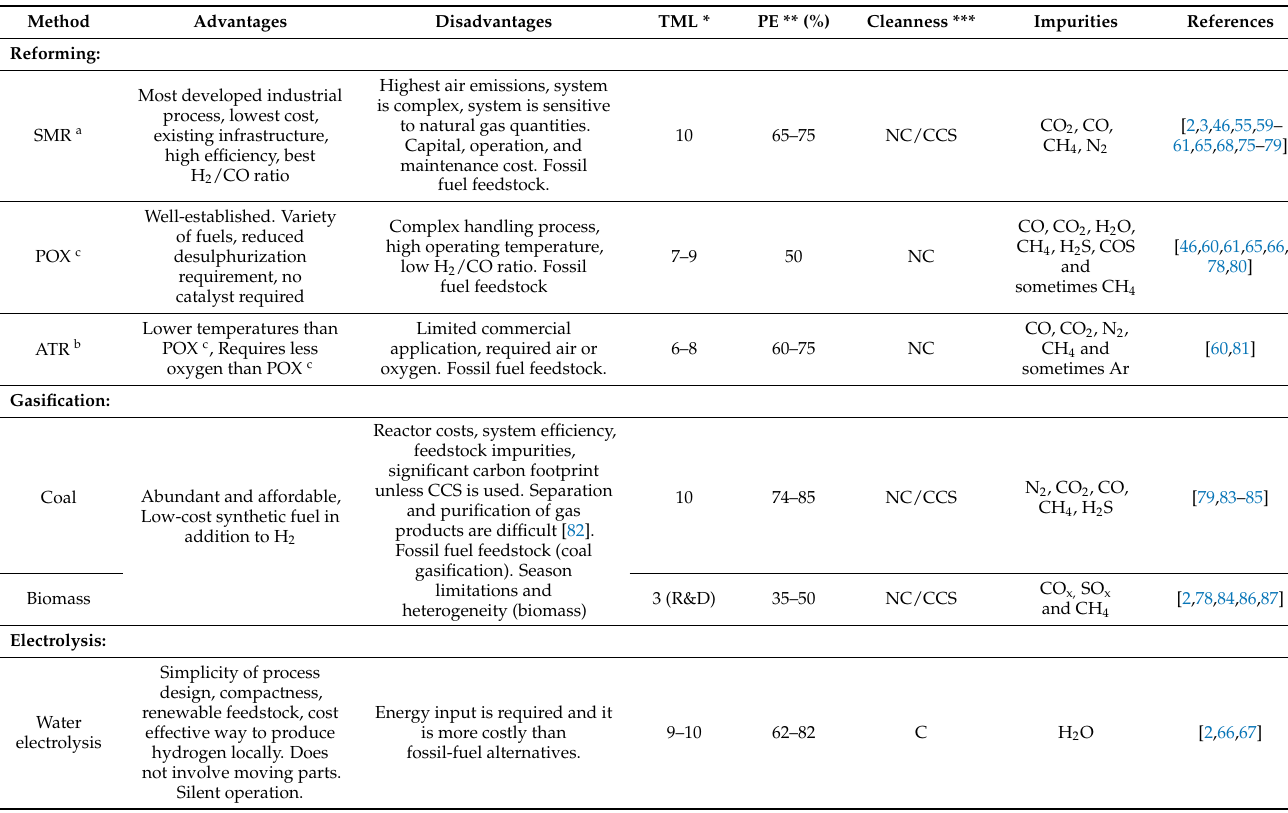
Table 1. Summary of hydrogen production processes, their advantages and disadvantages, and technological status.